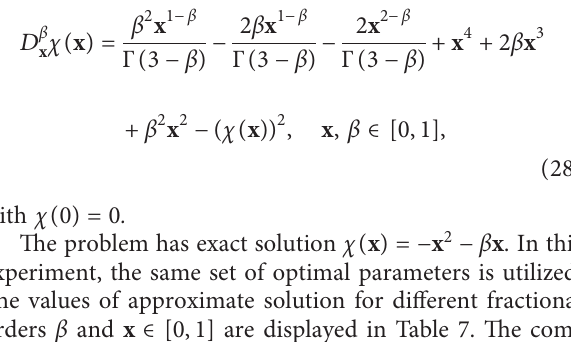
Figure 11: (a) Comparison between the absolute error and error observed. (b) The error function for β � 0 . 95 and various quadrature nodes corresponding to Problem